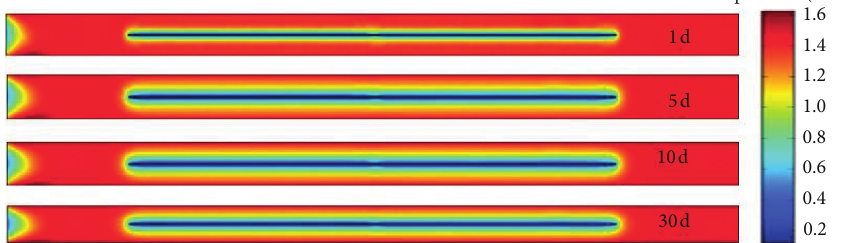
Figure 6: The gas pressure distribution of collapsed hole in the coal seam.